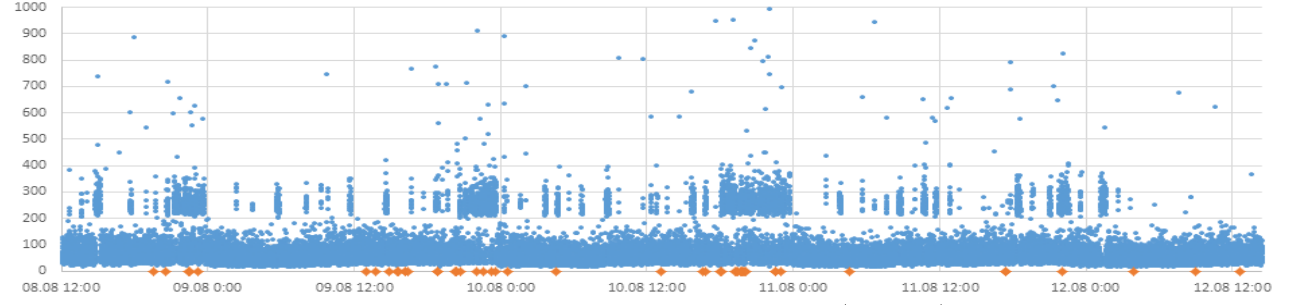
Fig. 13. RTT of heavily loaded Tele2 3G first endpoint (RTU server),